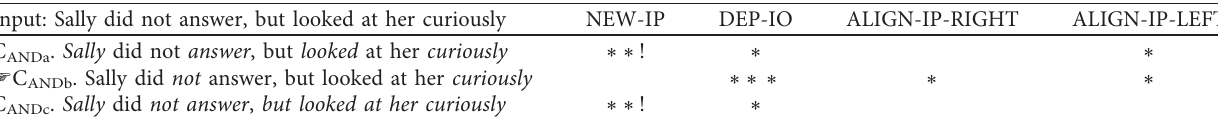
Table 5: An optimality-theoretic analysis of native